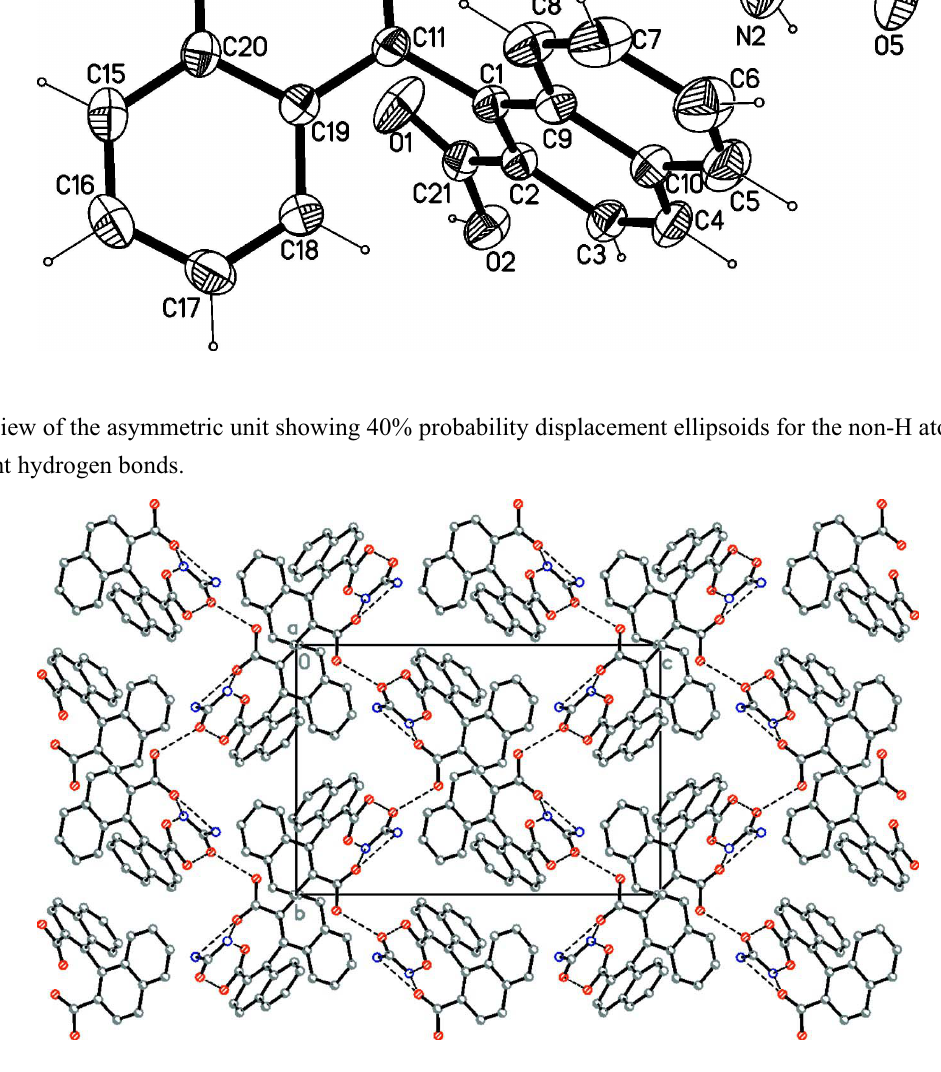
Figure 2 BNDA–urea hydrogen-bond assembly viewed down the a axis. H atoms have been ommited for clarity. Hydrogen bonds are shown as dashed lines. Red: oxygen, blue: